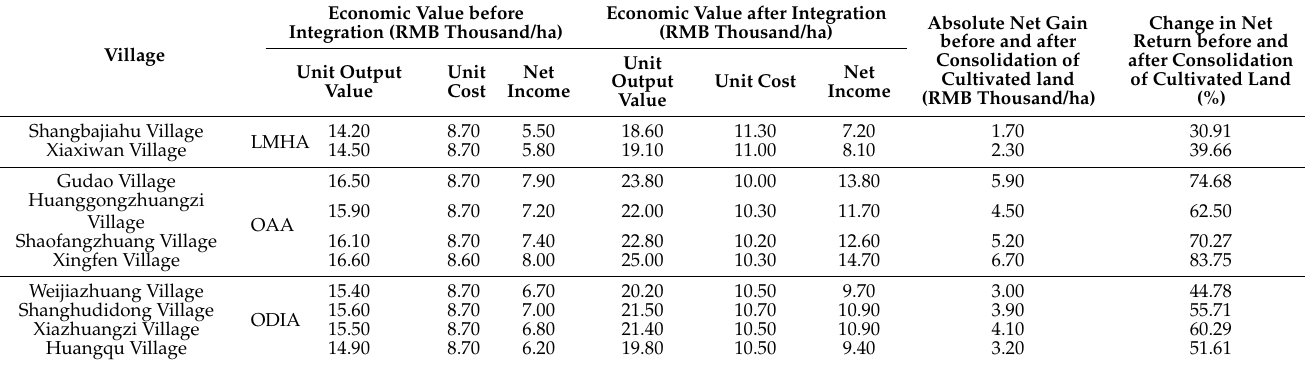
Change in Net Return before and after Consolidation of Cultivated Land (%)Unit Output